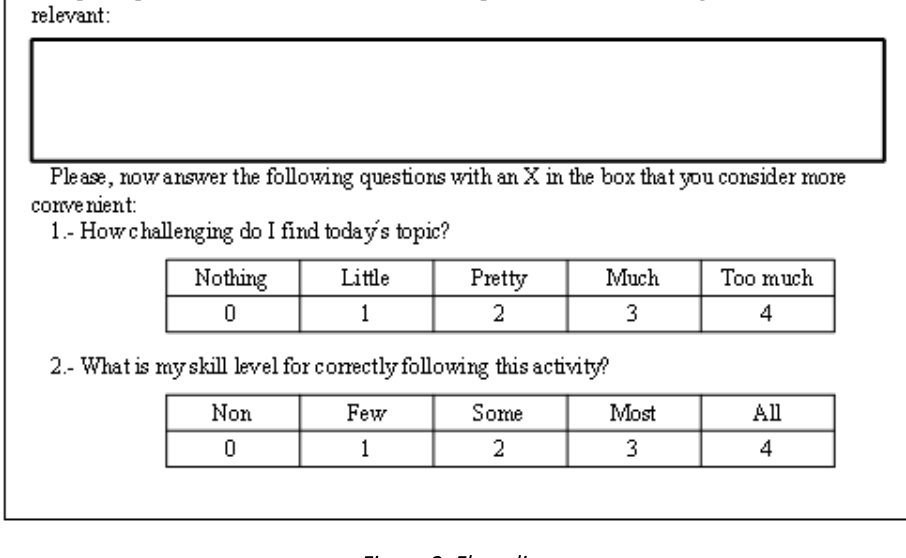
Figure 2. Flow diary